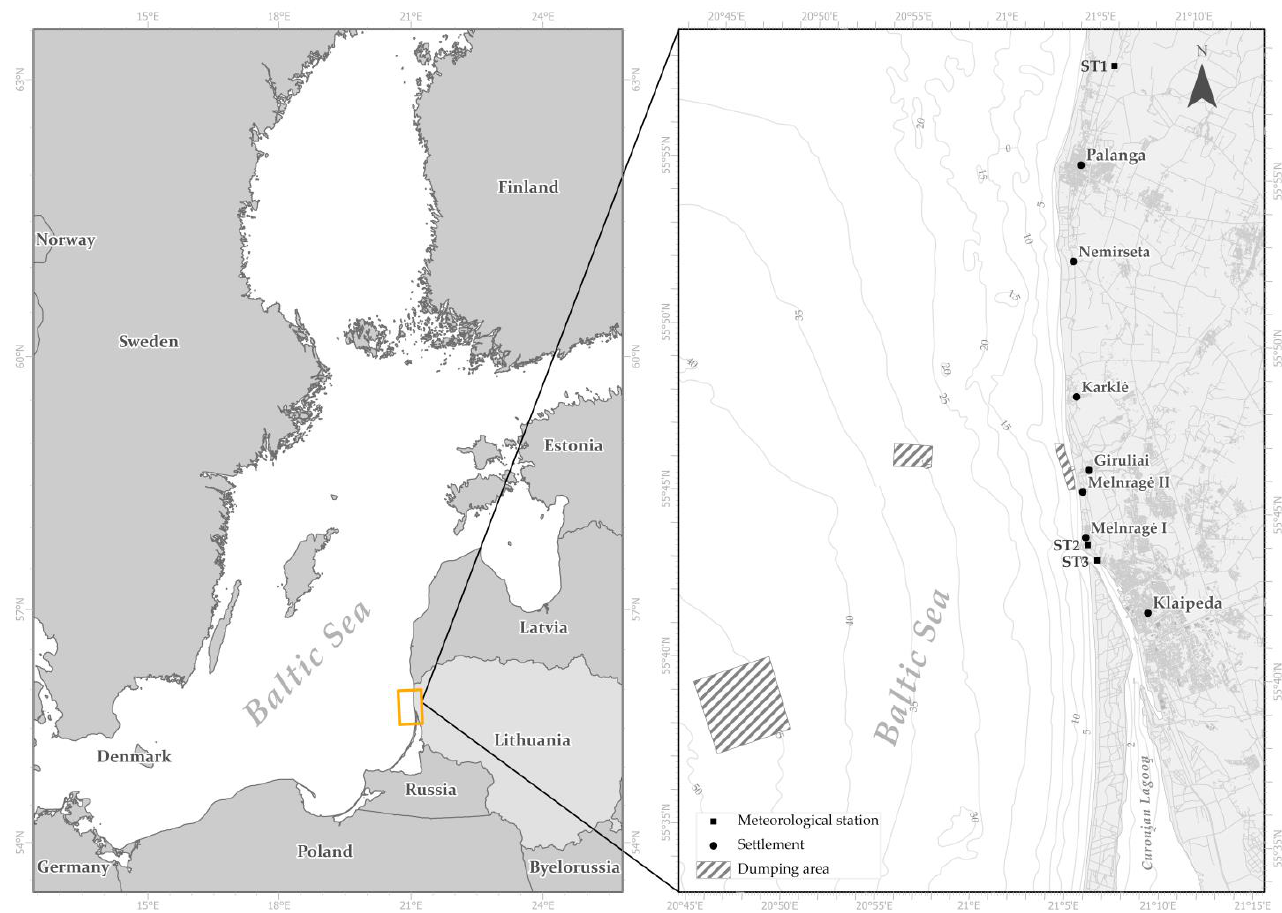
Figure 1. Overview of the study site. ST1 — Palanga Aviation meteorological station, ST2 —Klaipėda meteorological station, ST3 — Port of Klaipėda station.